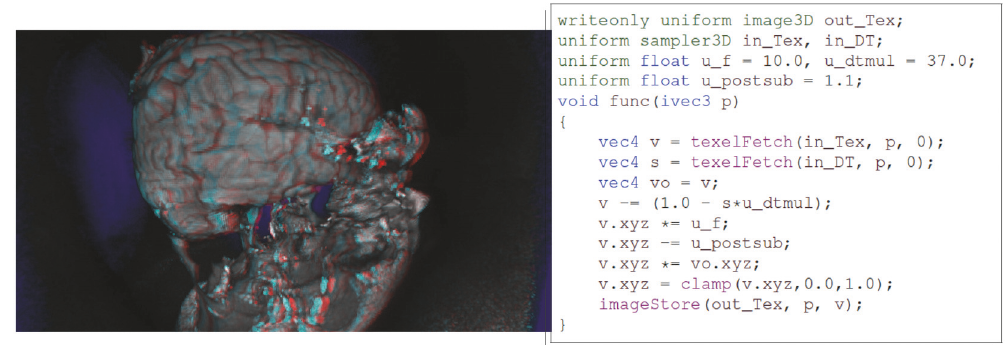
Figure 3: The distance transform from Table 1 combined with a custom compute node running the GLSL snippet on the right is a simple way to remove most of the skull in a head MRI scan. The result is red/cyan stereo-rendered.